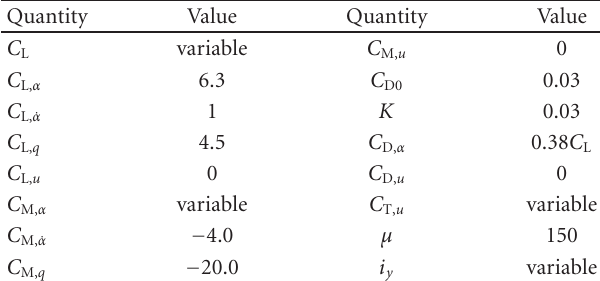
Table 1: Dimensionless stability derivatives of the model